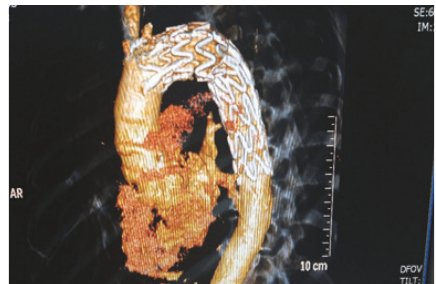
Figure 5: Three-dimensional CT angiography of thoracic aorta with proper placement of endograft and occlusion of left subclavian